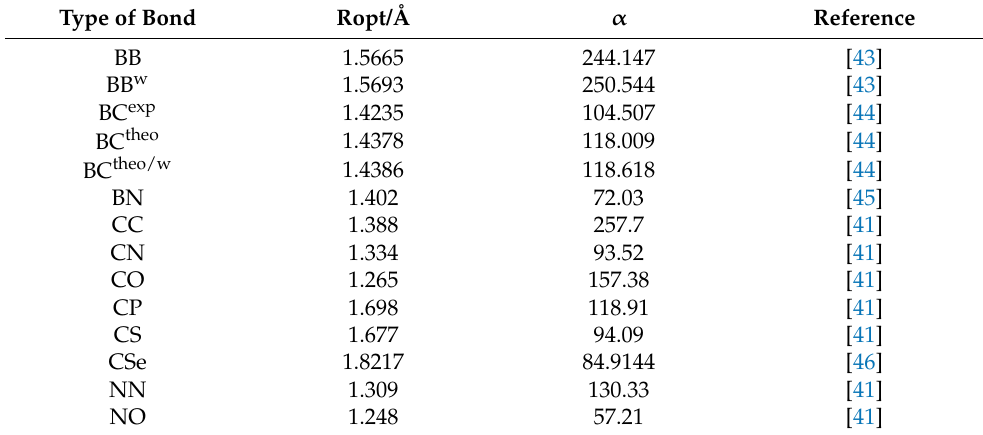
Table 2. Optimal bond lengths, R opt , and α values for different type of bonds used in the HOMA calculation (Equation